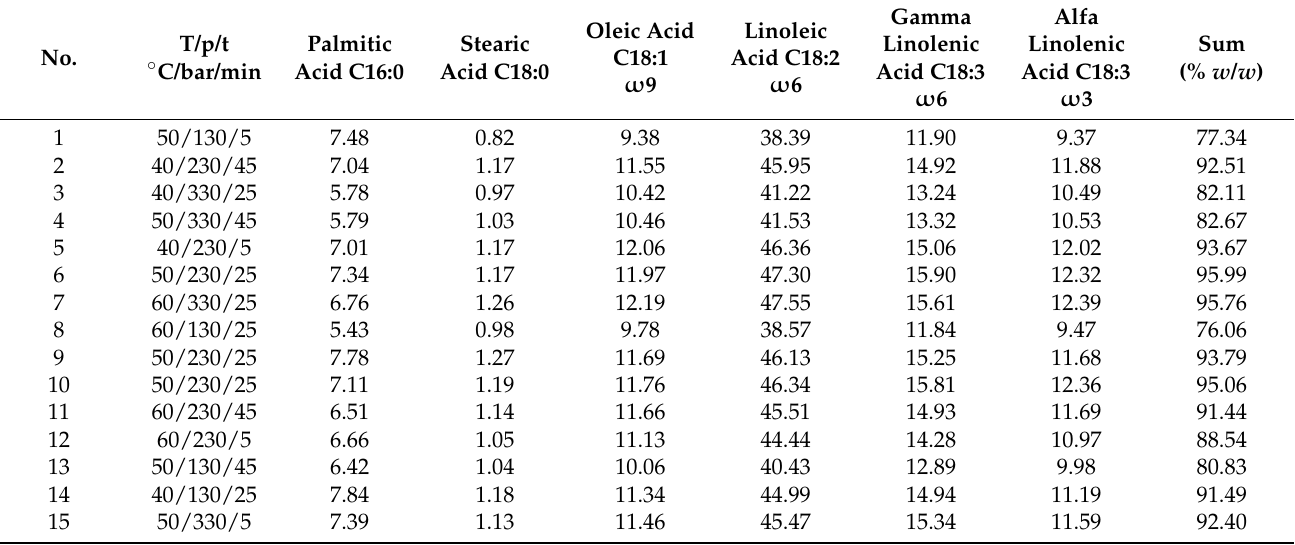
Table 7. The content of individual fatty acids in blackcurrant seed extracts (% w/w ) vs BBD experiment parameters.